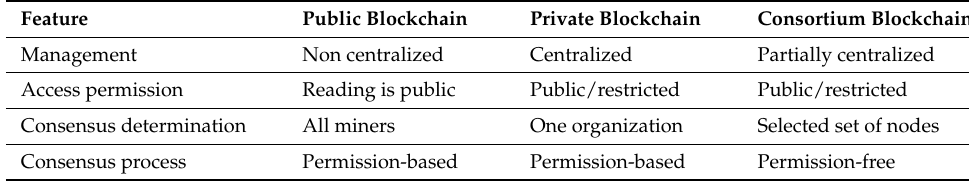
Table 2. Comparison of blockchain